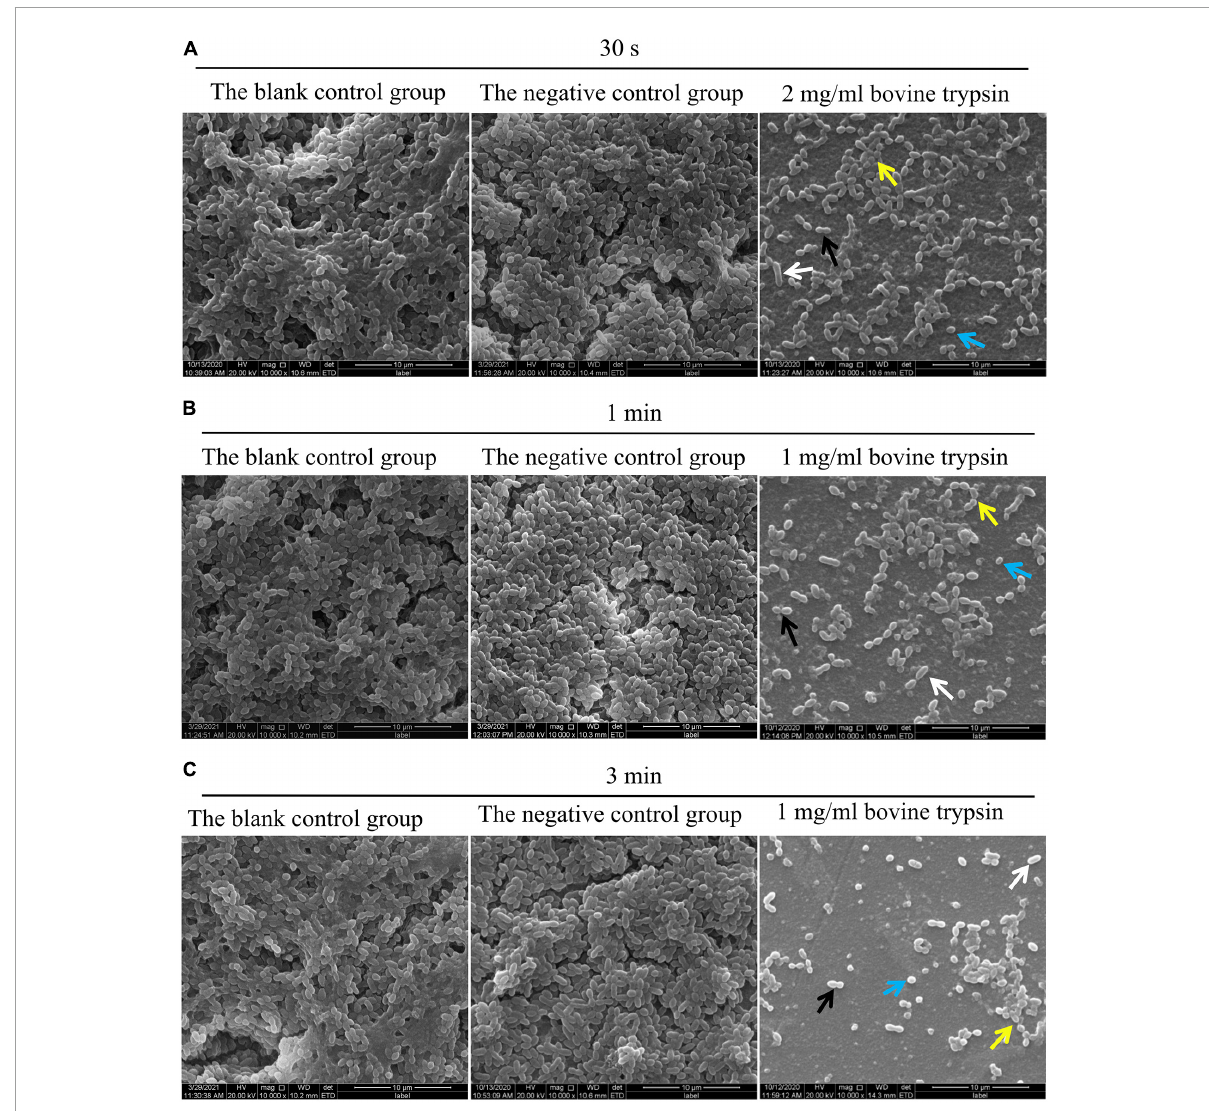
FIGURE2 SEM observation of biofilm morphology after bovine trypsin action. (A) The morphology of the biofilm after 2 mg/ml bovine trypsin treatment for 30 s ( × 1000). (B) The morphology of the biofilm after 1 mg/ml bovine trypsin treatment for 1 min ( × 1000). (C) The morphology of the biofilm after 1 mg/ml bovine trypsin treatment for 3 min ( × 1000). The short rod-shaped bacteria (white arrows), the paired ball-shaped bacteria (black arrows), the small spherical bacteria (blue arrows), and the bacteria arranged in short chains (yellow